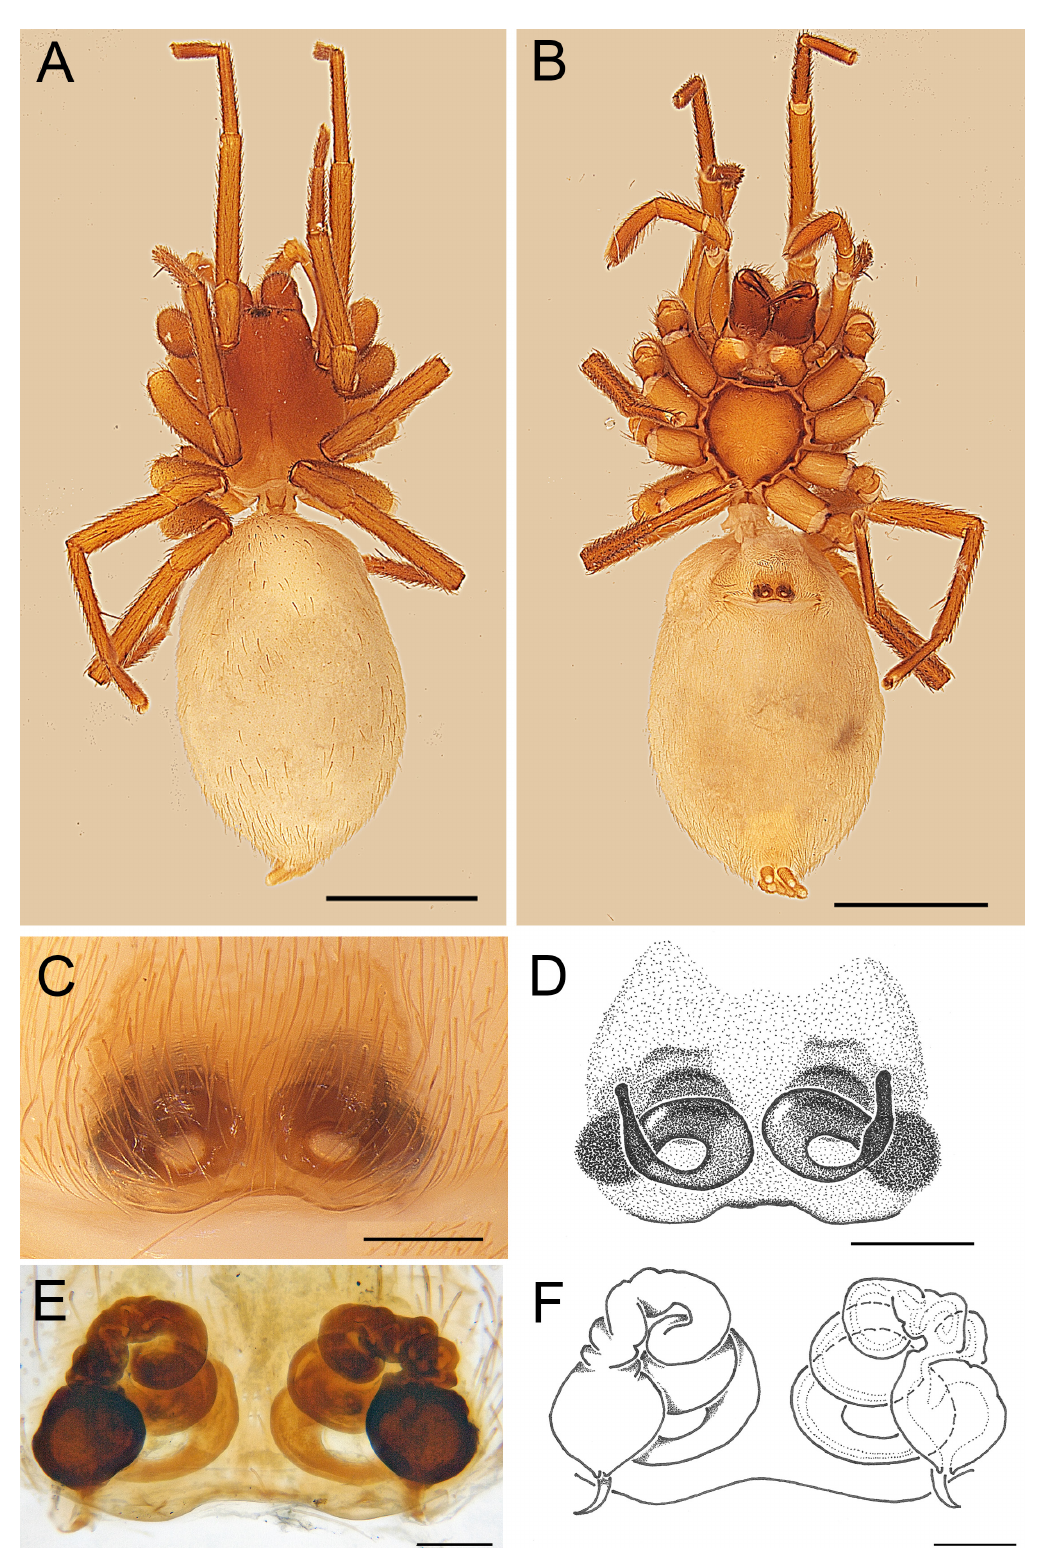
Fig. 8. Andromma alvoculatum sp. nov., ♀, holotype (BE_RMCA_ARA.Ara 240739). A . Habitus, dorsal view. B . Same, ventral view. C–D . Epigyne, ventral view. E–F . Same, cleared, dorsal view. Scale bars: A–B = 2 mm; C–D = 0.2 mm; E–F =